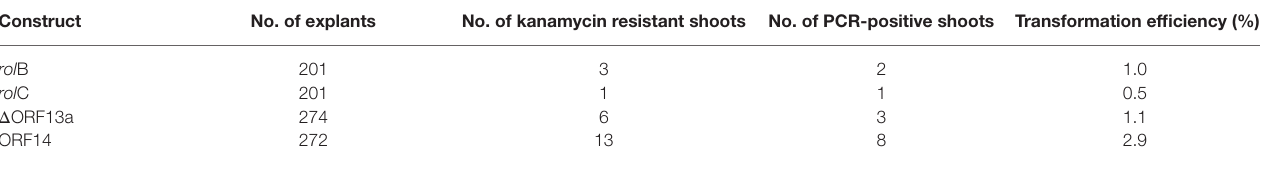
TABLE 1 | Overall Agrobacterium tumefaciens transformation data. Number of inoculated explants, kanamycin resistant shoots and confirmed by PCR amplicon sequencing, and transformation efficiency for the investigated constructs.